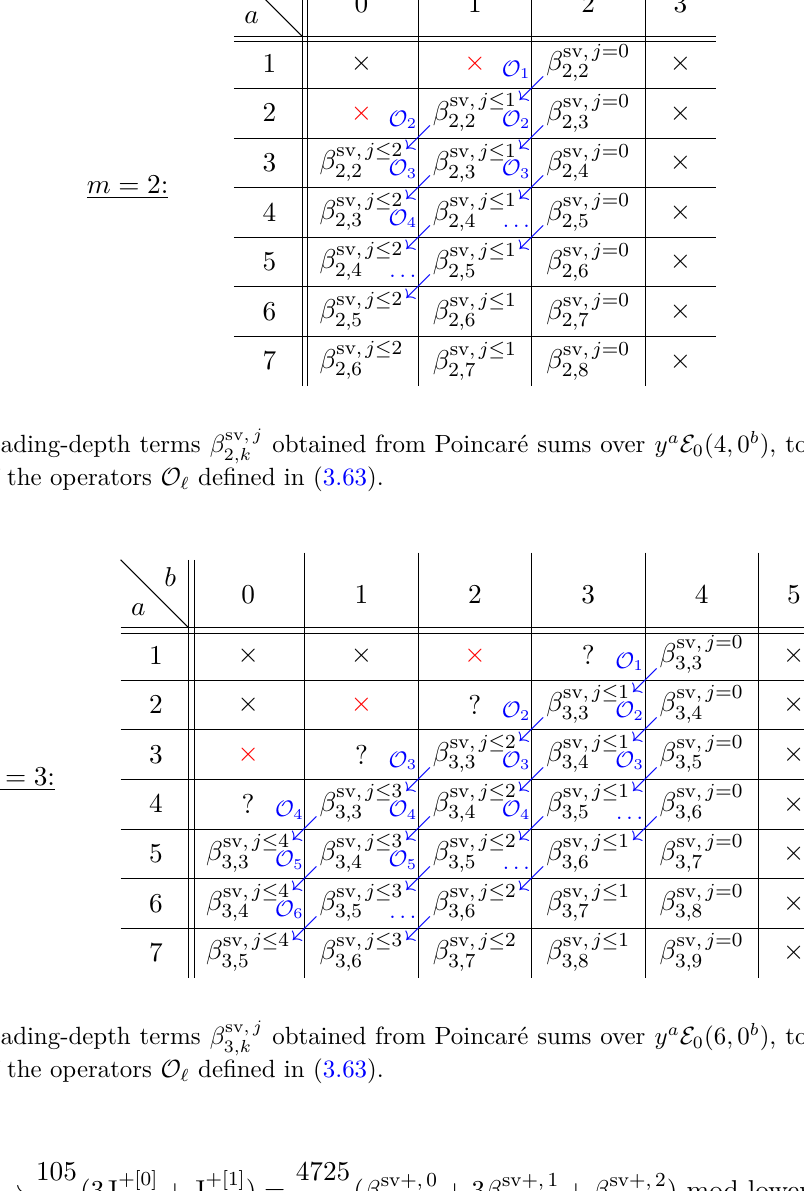
Table 2 . Leading-depth terms β sv ,j the action of the operators O